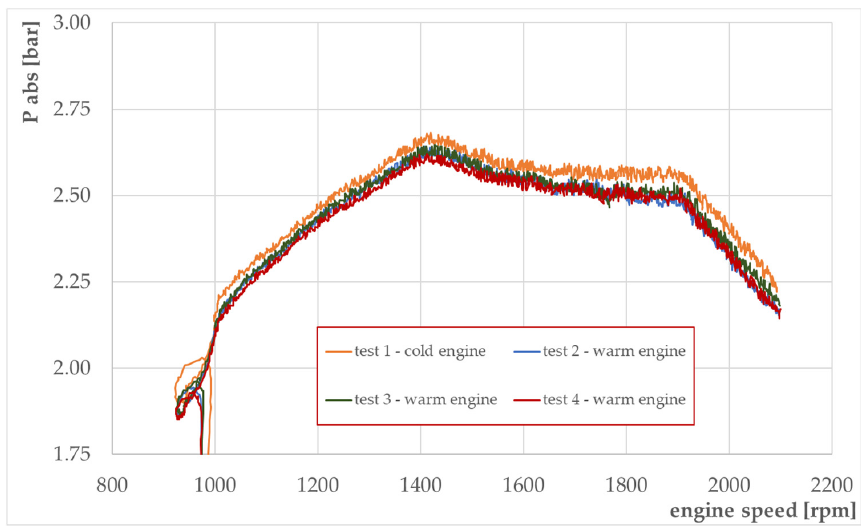
Figure 15. Graph of the repeatability of the boost pressure build-up due to the measurement condi- tions (engine warm-up) (authors’ source).